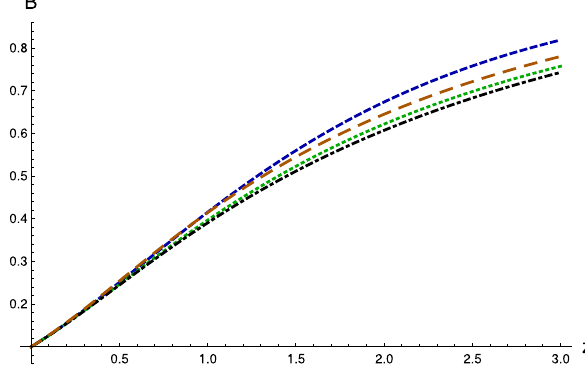
Fig. 2 The evolution of the anisotropy parameter as a function of red- shift z for β = 0 . 001 (dashed), 0 . 05 (dotted), 0 . 1 (dot-dashed) and 0 . 5 (long dashed)